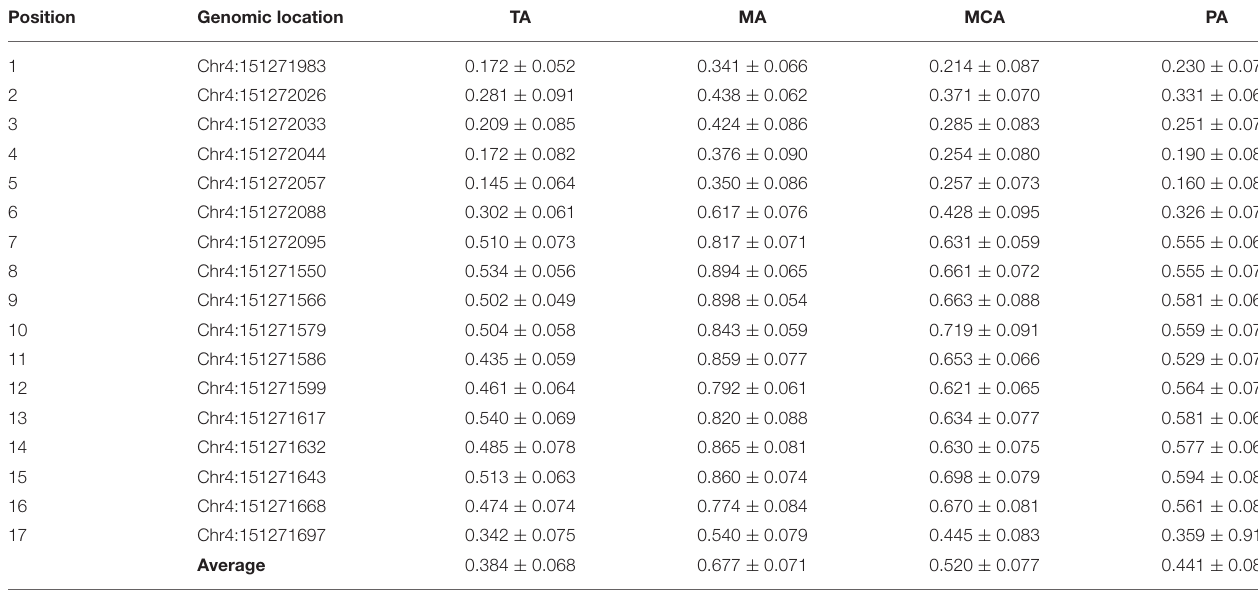
TABLE 2 | Methylated CpG sites in CACNA1C promoter measured in this study. Position Genomic